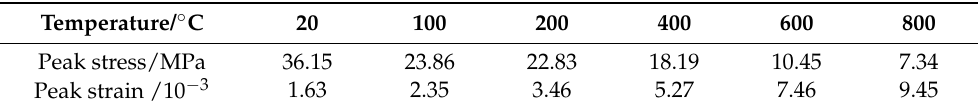
Table 2. Peak stress and peak strain of the uniaxial compressive test after different heated temperatures.